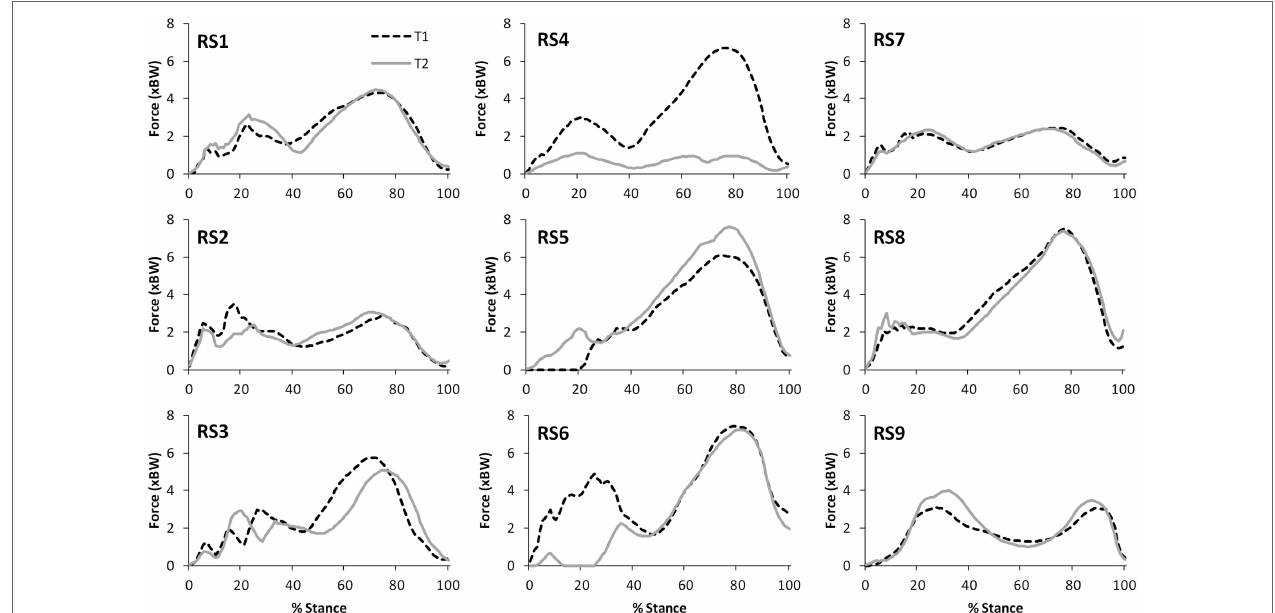
FIGURE 4 | A comparison of the subject specific variation (between test sessions 1 and 2) in predictions of tibiofemoral joint contact forces during gait.